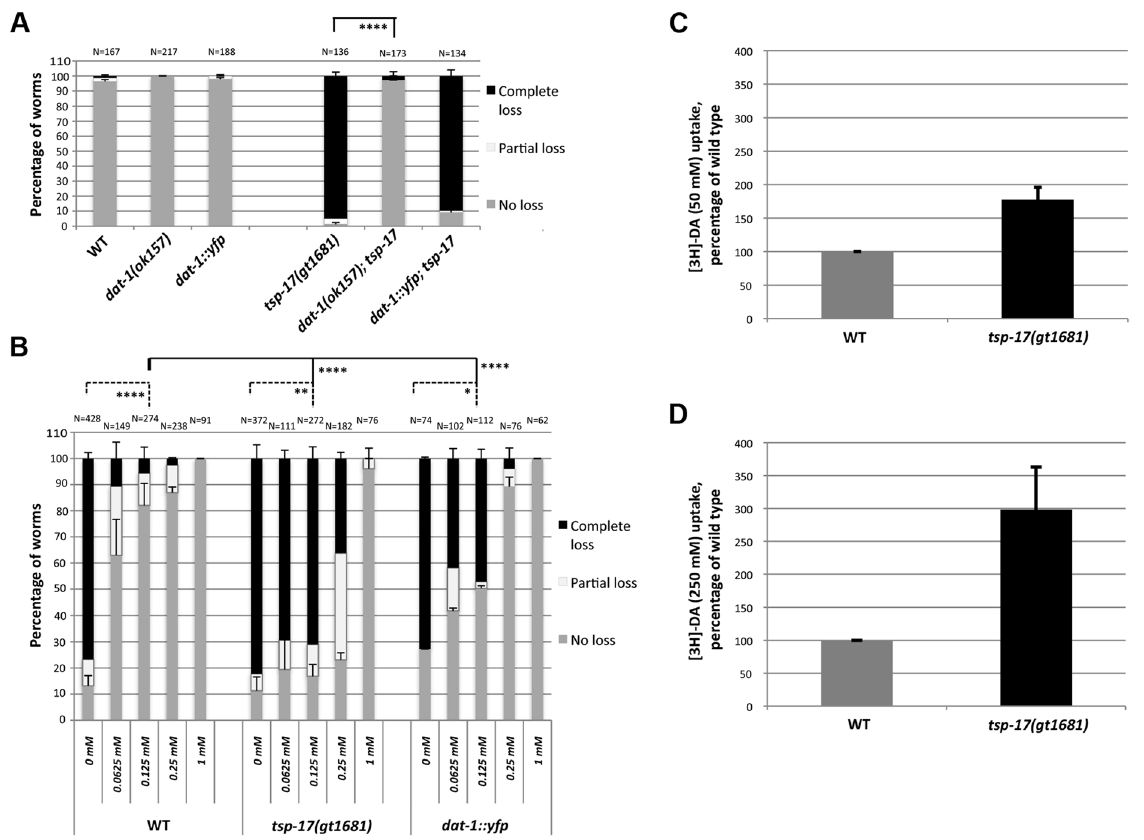
Figure 6. Evidence for DAT-1 hyperactivation in tsp-17 worms. A . dat-1::yfp transgenic worms (TG2470) do not exhibit hypersensitivity to 10 mM 6-OHDA. The extent of neurodegeneration was scored 72 h post 6-OHDA intoxication. Asterisks represent statistically significant differences compared to tsp-17 worms (****p , 0.00001) B . More imipramine than in wild-type worms is needed to prevent neurodegeneration in tsp-17 mutants and in dat-1::yfp overexpression worms co-treated with 50 mM 6-OHDA. Data presented is from scoring the extent of neurodegeneration 72 h post 6- OHDA intoxication. The imipramine concentration is indicated on the x axis. N, total number of worms from each strain examined for every treatment. Error bars represent the standard error of the mean. Asterisks (below top bar) represent statistically significant differences compared to wild-type; worms treated with 0.125 mM imipramine are compared (****p , 0.00001). Lower bars indicate difference within individual strains (no imipramine compared to 0.125 mM imipramine; *p , 0.05, *p , 0.005, ****p , 0.00001) C., D . [ 3 H]-dopamine (DA) uptake in wild-type and tsp-17 worms. Uptake assays were performed using 50 nM ( C ) and 250 nM [ 3 H]-DA ( D ).